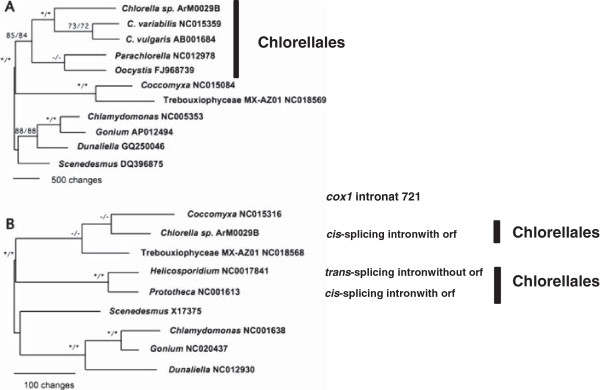
Single maximum parsimonious (MP) trees. A. The plastid MP tree from DNA sequences of rbcL and six photosystem genes. B. The mt MP tree from translated amino acid sequences of seven protein-coding genes. The distribution of cox1 intron at 721, its splicing form, and presence/absence of its orf were denoted. */*: 100% bootstrap support/100% jackknife support. −/−: bootstrap and jackknife not supported.